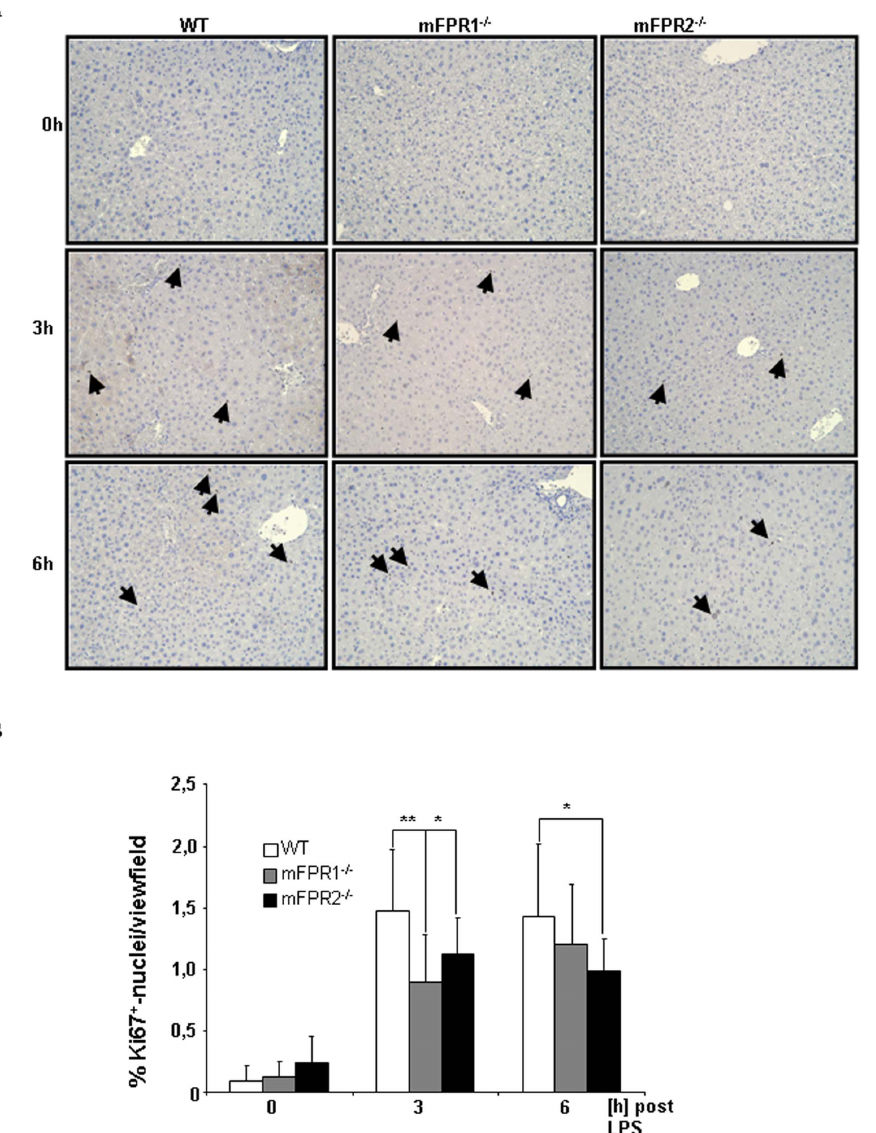
Figure 7. To investigate liver proliferation FFPE-sections were stained with the universal cell cycle marker Ki67. At 3 h and 6 h post LPS Ki67 + -nuclei were counted and analyzed as percentage of proliferative cells. Photomicrographs were taken at 200-fold and representative images are shown. Ki67 + -nuclei are indicated by arrows (*=p , 0.05; **=p , 0.01).